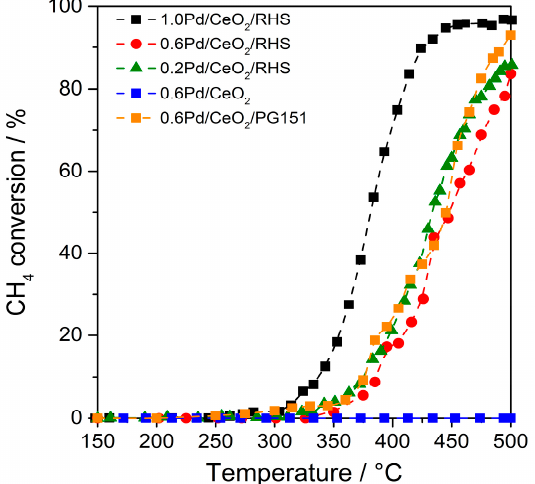
Figure 6. Effect of water on methane catalytic activity of 0.6Pd/CeO 2 , 0.2Pd/CeO 2 /RHS, 0.6Pd/CeO 2 /RHS, 1.0Pd/CeO 2 /RHS, and 0.6Pd/CeO 2 /PG151 in wet feed gas (0.1 vol%-CH 4 , 9.0 vol%-O 2 , 5.5 vol%-CO 2 and 10.5 vol%-H 2 O balanced with N 2 ); 0.2 g catalyst, 300 mL/min flow rate; modified GHSV = 90.000 L kg cat − 1 h − 1 .